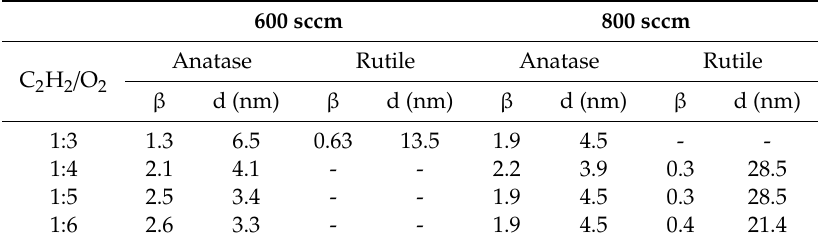
Table 1. The grain sizes of anatase and rutile under various processing conditions. 600 sccm 800 sccm C 2 H 2 /O 2